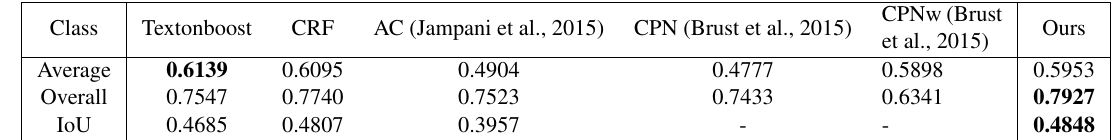
Table 2. The quantitative results on the LabelMeFacade dataset. Textonboost is trained using Automatic Labelling Environment. The CRF is a 4-connected CRF. AC is the Auto-context method. CPN is the Convolutional Patch Networks method. CPNw is the wighting version of Convolutional Patch Networks method. Our method is the fully connected